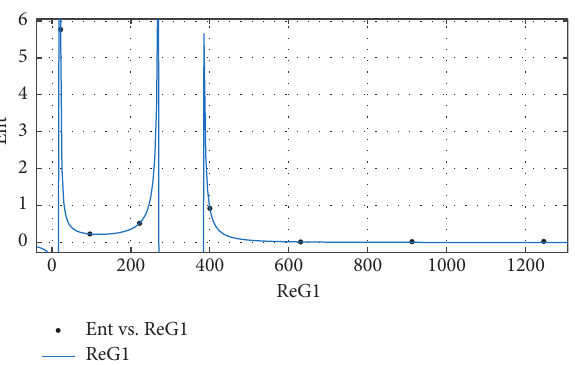
Figure 17: Entropy ( Re G